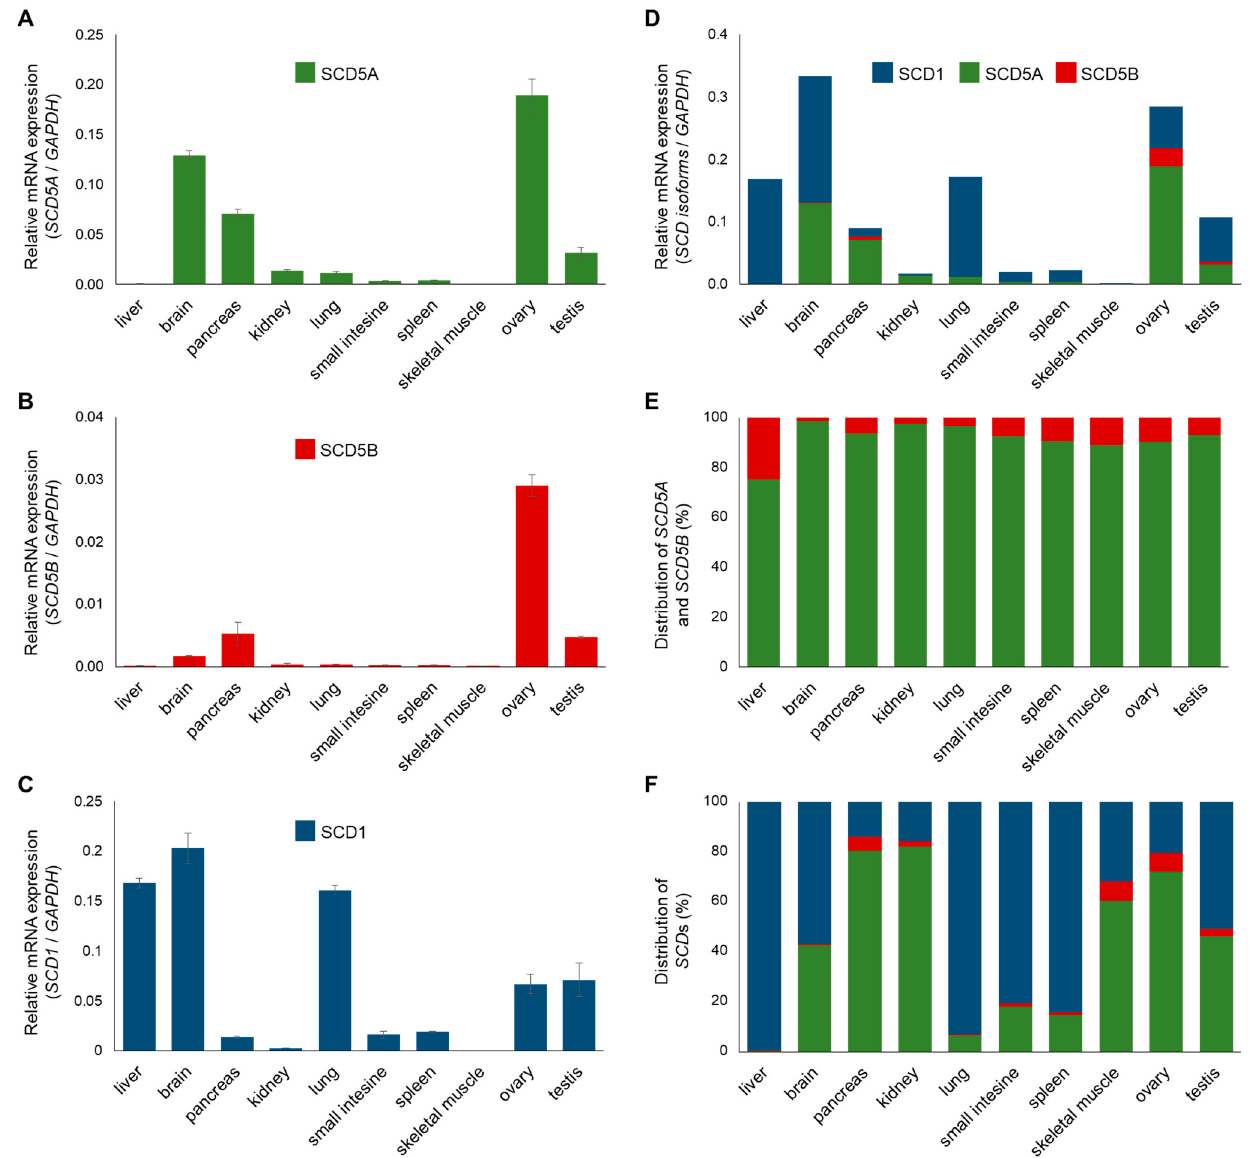
Figure 2. Relative gene expression and distribution of human SCD s in different tissues. Relative mRNA expression of SCD5A ( A ), SCD5B ( B ), SCD1 ( C ) and cumulated relative SCD gene expression ( D ) were measured in ten different human tissues by qPCR, as described in Section 4. GAPDH gene expression served as a control. The distribution of SCD5 transcript variants ( E ) and all three SCD mRNAs ( F ) in human tissues is represented on a percentage scale, where total SCD5 or total SCD expression is considered as 100 percent. Experiments were performed in triplicate. In charts ( A – C ), data are shown as the mean values ± S.D. The S.D. values for sections ( D ), ( E ) and ( F ) are presented in Tables S2, S3 and S4, respectively.